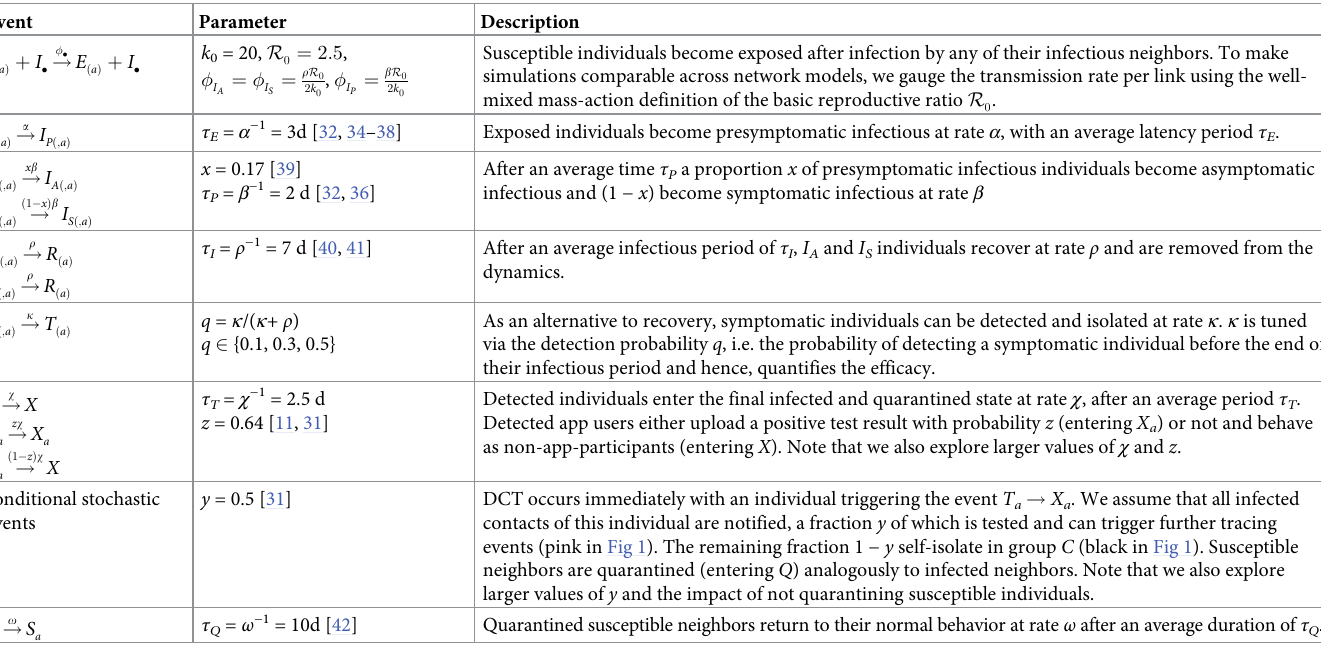
Table 1. Events, parameters and description of the infectious disease model used in this study. Compartments of app participants are marked with subscript a . Events that are equal for app participants and non-users are marked with subscript ( a ), e.g. A ( a ) ! B ( a ) . Rates of events are displayed above the arrows. Event Parameter